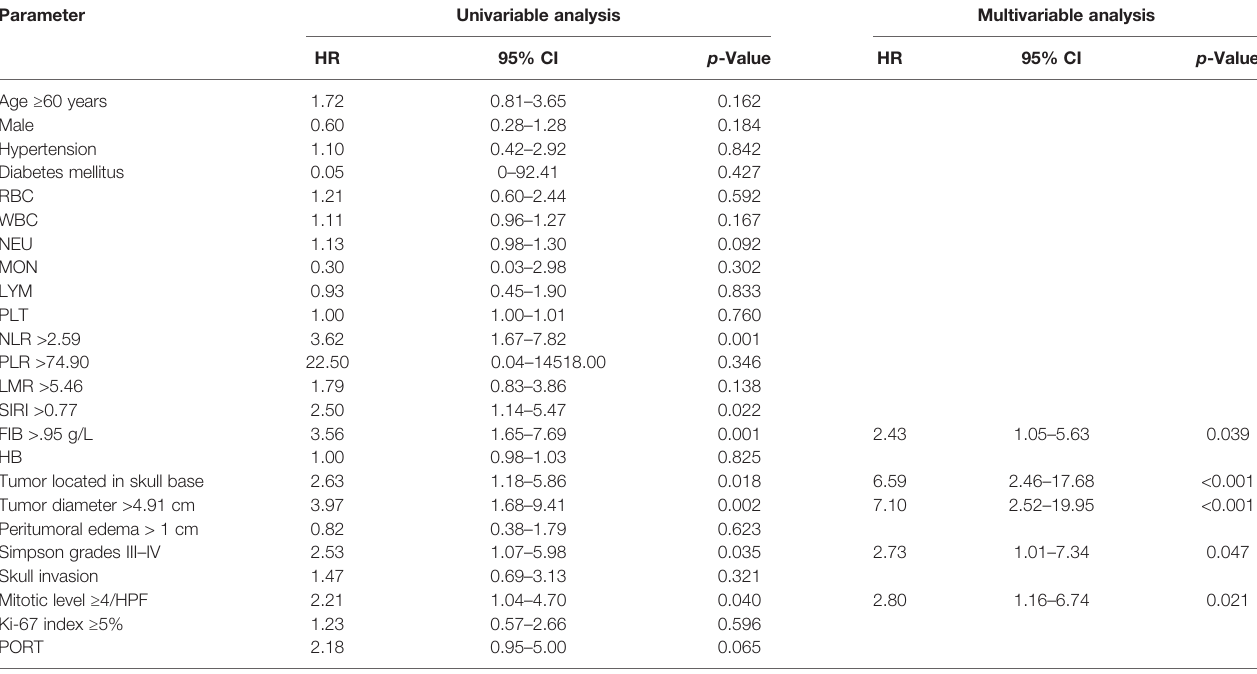
TABLE 3 | Univariable and multivariable cox hazard regression analyses of recurrence in the training cohort. Parameter Univariable